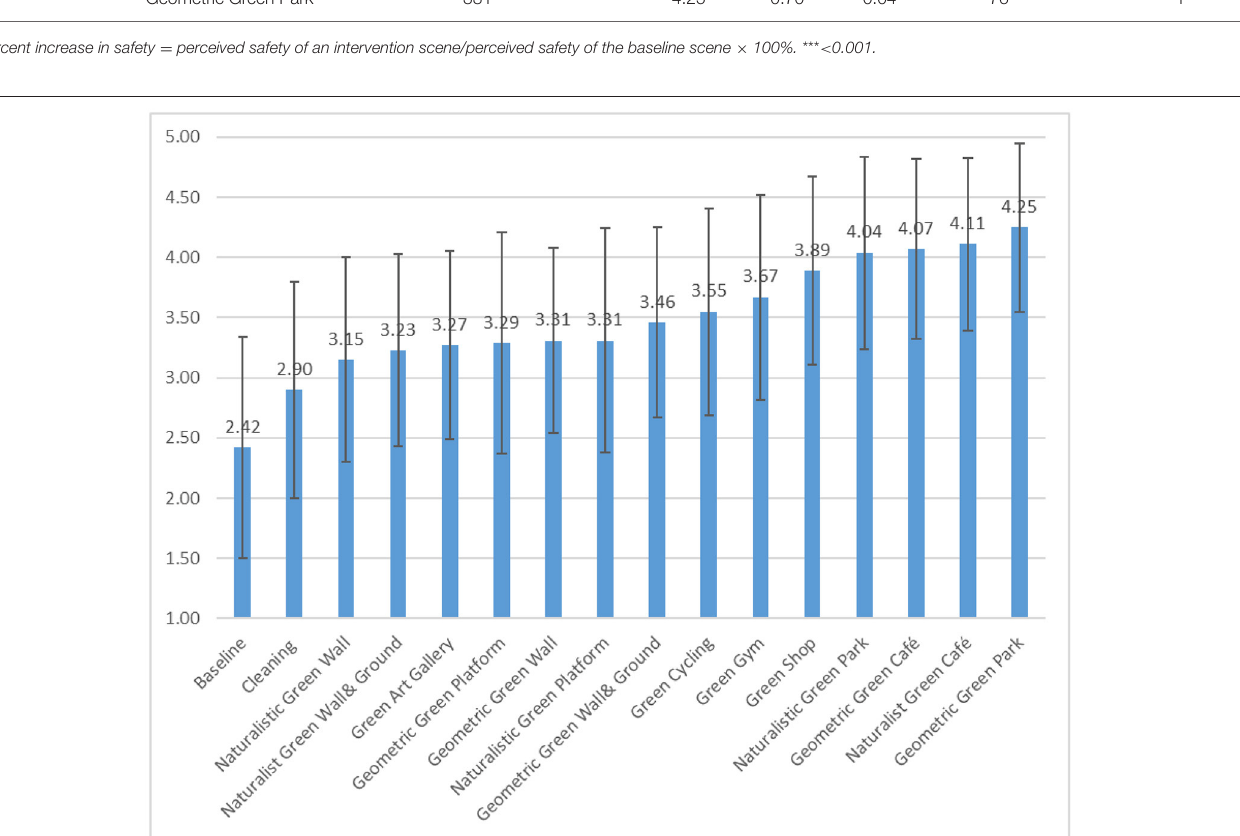
The Green Shop intervention, the two Green Parks, the two Green Café interventions, and the Green Outdoor Gym. One urban function intervention yields a greater but non-significant